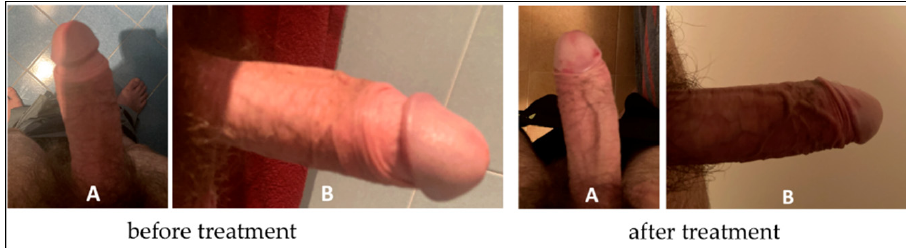
Figure 11. Case 3. Anterior ( A ) and lateral ( B ) photographic poses (before and after treatment).